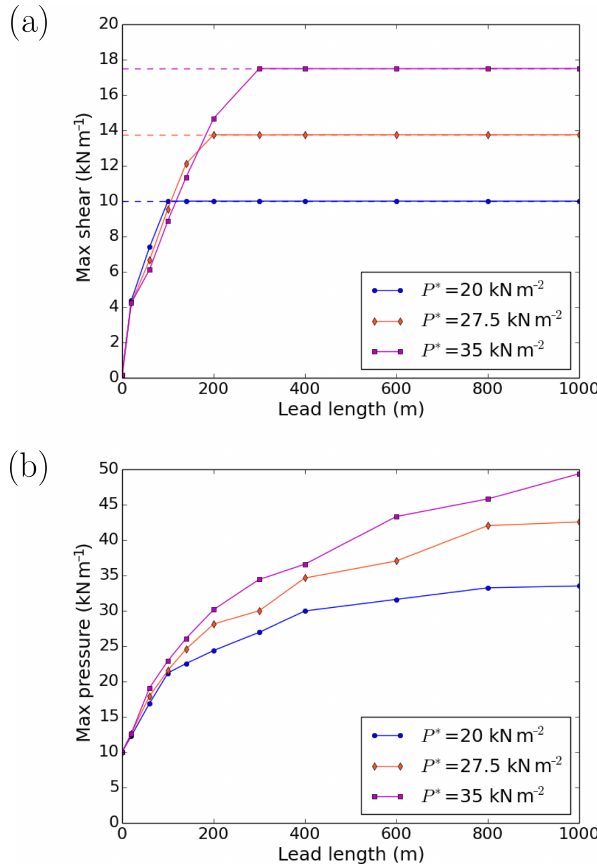
Figure 5. Maximum value of the shear stress invariant ( a ; kNm − 1 ) and of the pressure ( b ; kNm − 1 ) in the domain as a function of lead length for different values of the parameter P ∗ ( P ∗ = 20kNm − 2 : blue; P ∗ = 27.5kNm − 2 : orange; P ∗ = 35kNm − 2 : magenta). The thickness field is 2m everywhere except the 10m wide horizontal lead in the middle of the domain. The normal stresses at the bound- aries are − 10kNm − 1 .